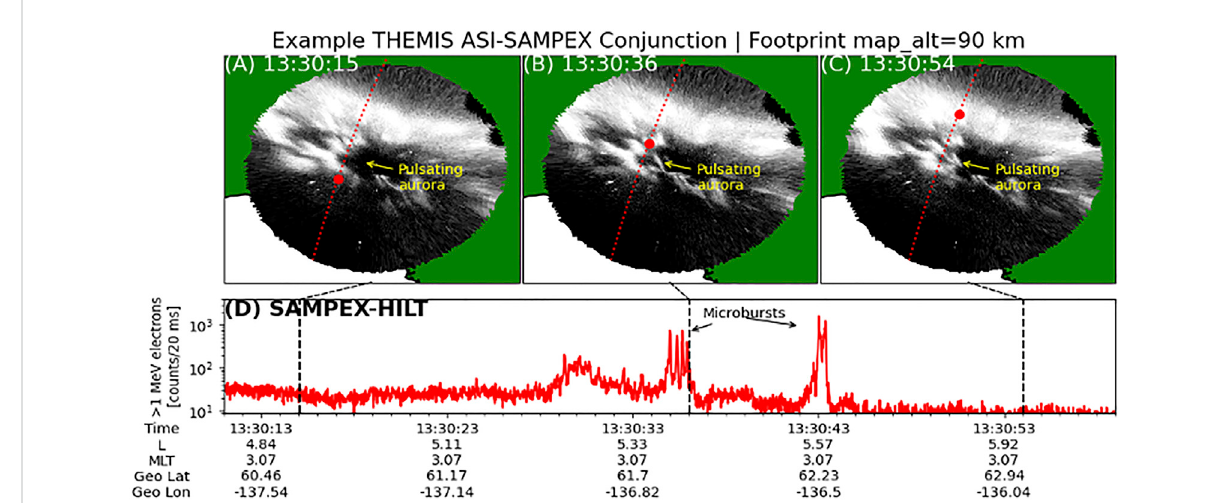
An example THEMIS ASI-SAMPEX conjunction with concurrent pulsating aurora and relativistic microbursts. (A – C) show auroral images projected onto a geographic map. Superposed on the map are the full and instantaneous SAMPEX satellite footprints, shown by the red dotted line and circle, respectively. (D) shows the > 1 MeV electron precipitation observed by the HILT instrument onboard SAMPEX. Microbursts were clearly observed between 13:30:33-13:30:43 while SAMPEX passed through pulsating aurora patches. The minor ticks are at every